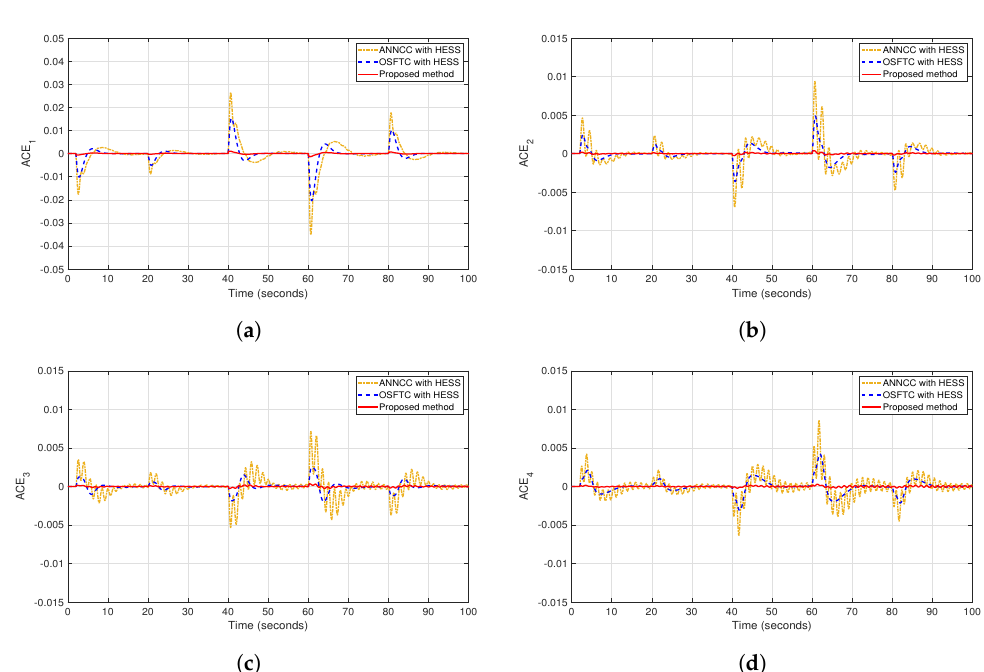
Figure 7. The ACE i (area control error) of each area subjected to the load disturbances shown in Figure 5: ( a ) ACE 1 ; ( b ) ACE 2 ; ( c ) ACE 3 ; and ( d ) ACE 4